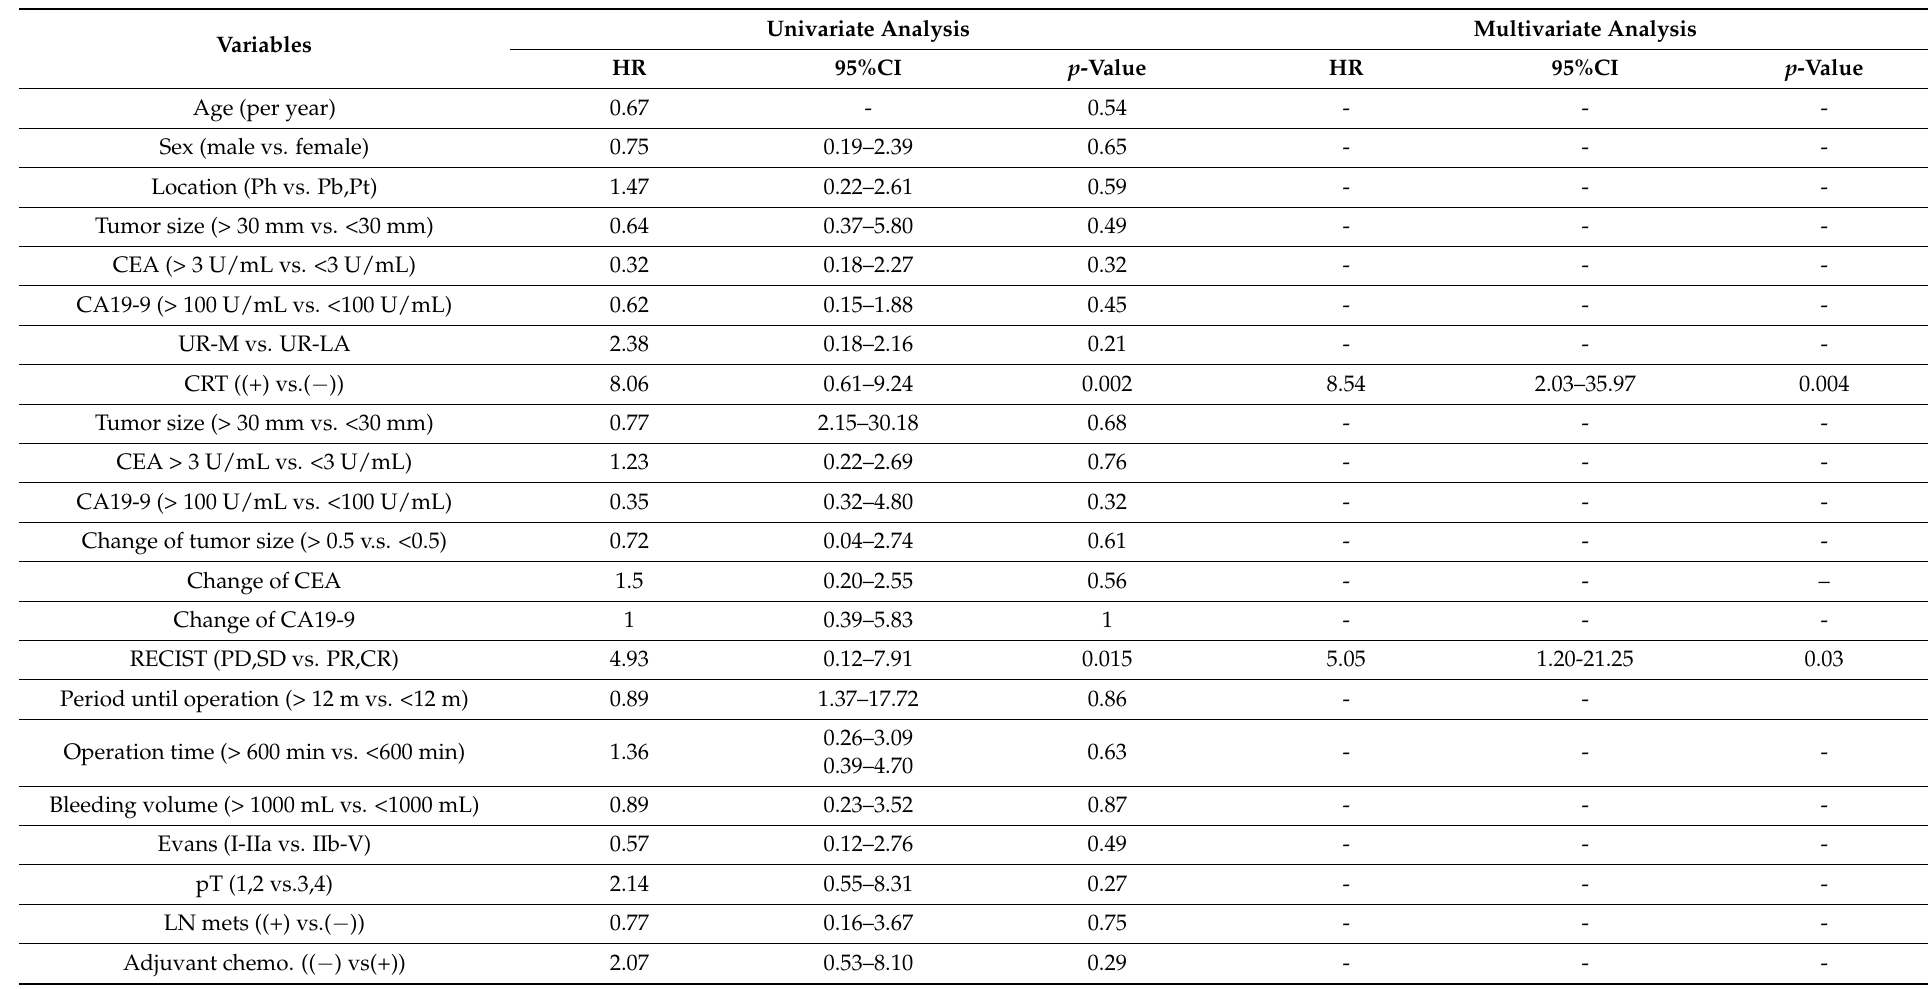
Table 4. Predictive factors for the overall survival of patients with unresectable pancreatic cancer (univariate and multivariate logistic regression analyses).